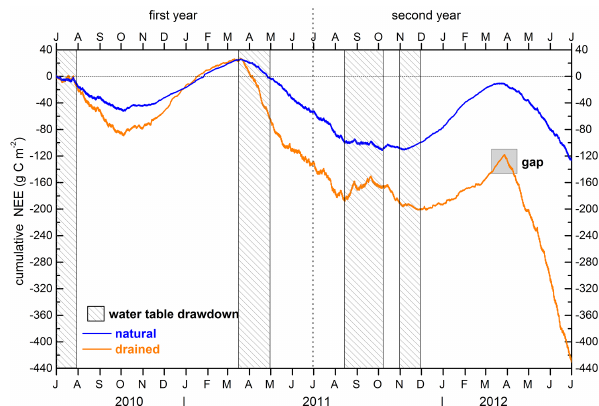
Figure 8. Cumulative NEE at both sites over the whole measure- ment period (1 July 2010–30 June 2012). The grey shaded box marks a long data gap at the drained site due to power failure. The dotted vertical line shows the end of the first annual cycle. The hor- izontal dashed line highlights the zero line; negative slope of NEE represents carbon uptake and positive values carbon release. Uncer- tainty intervals are not shown for